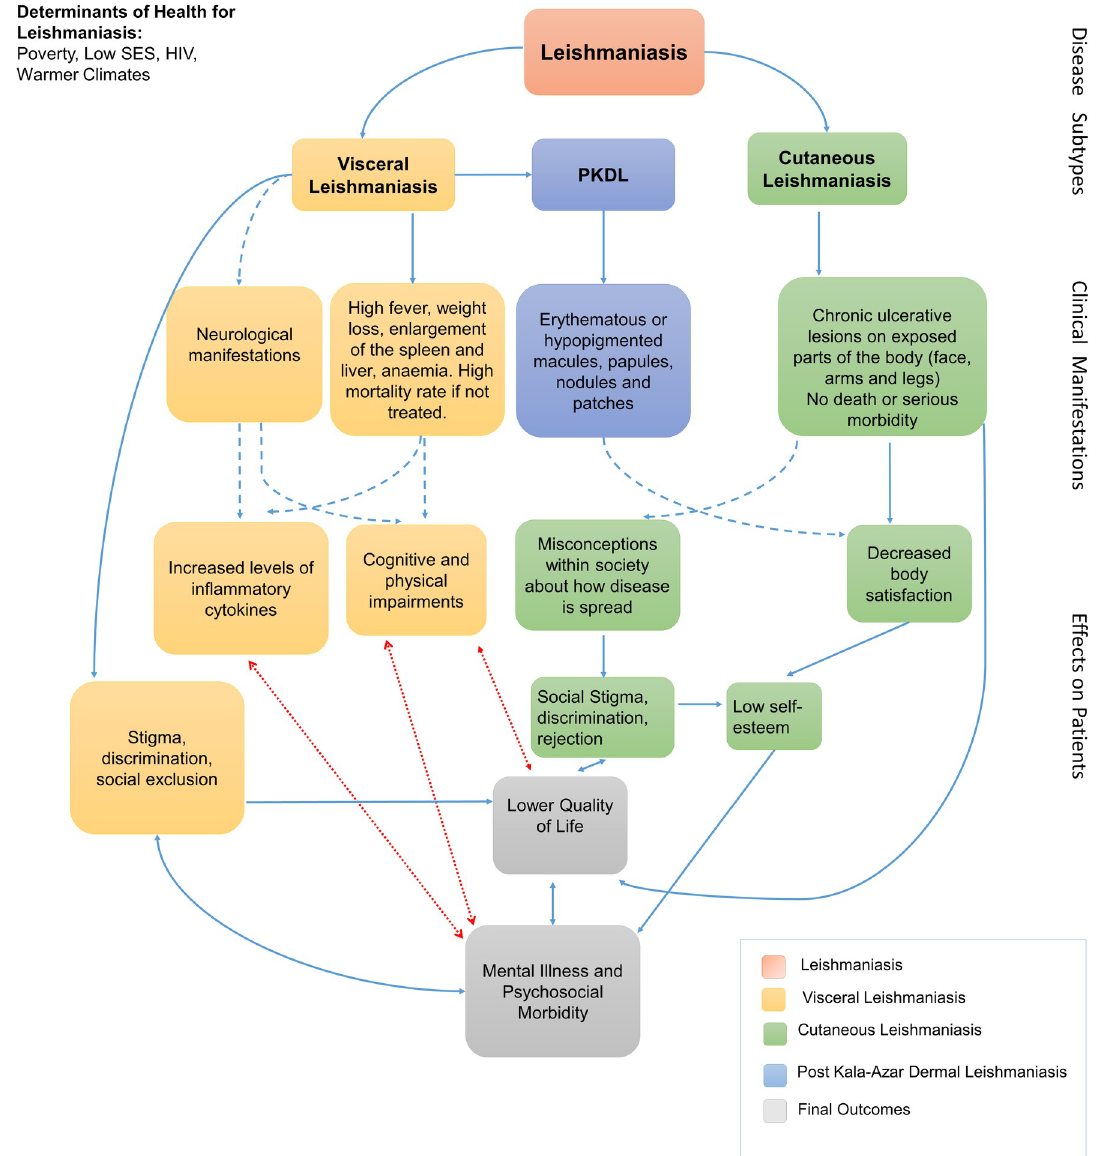
Fig 1. Conceptual Framework. Theoretical model linking leishmaniasis to decreased quality of life, mental illness and psychosocial morbidity. Continuous blue arrows show links that were confirmed in the included studies, dotted blue arrows show links that have been established in the literature but were not mentioned in our included studies, and red arrows show theoretical links that were hypothesized for this systematic review but not confirmed in the